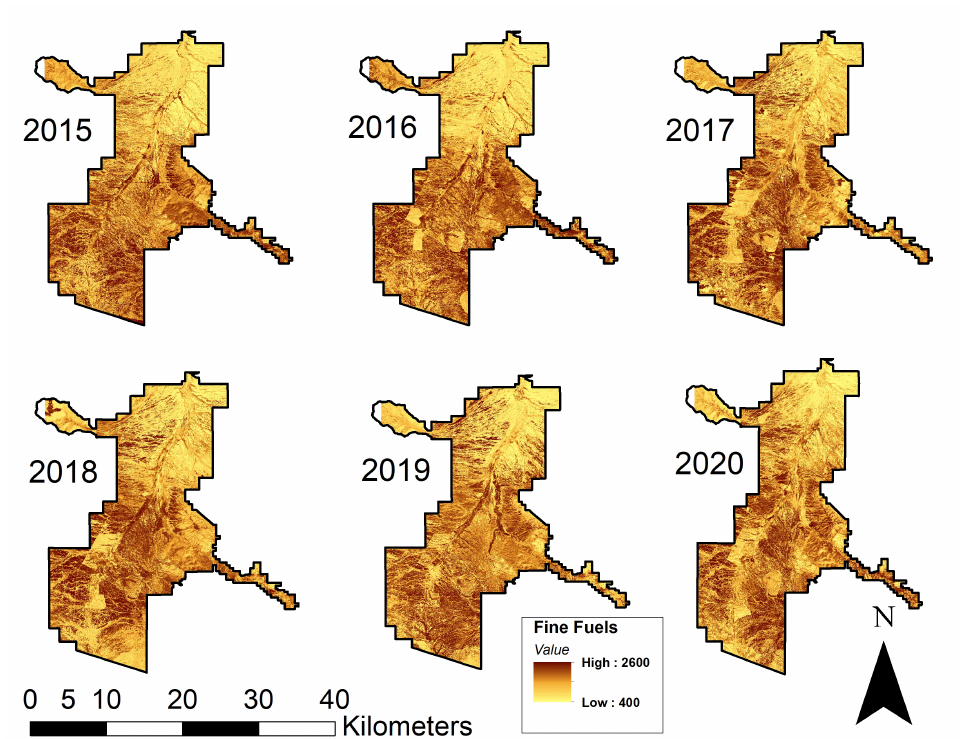
Figure 4. Serial model of fine-fuels (kg/ha) estimated from 2015 to 2020 with Sentinel-2A imagery across